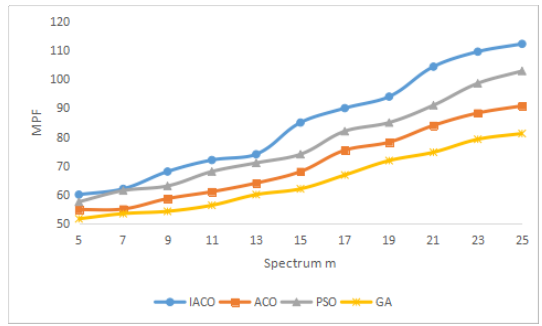
Figure 6. MPF change with N = 15.